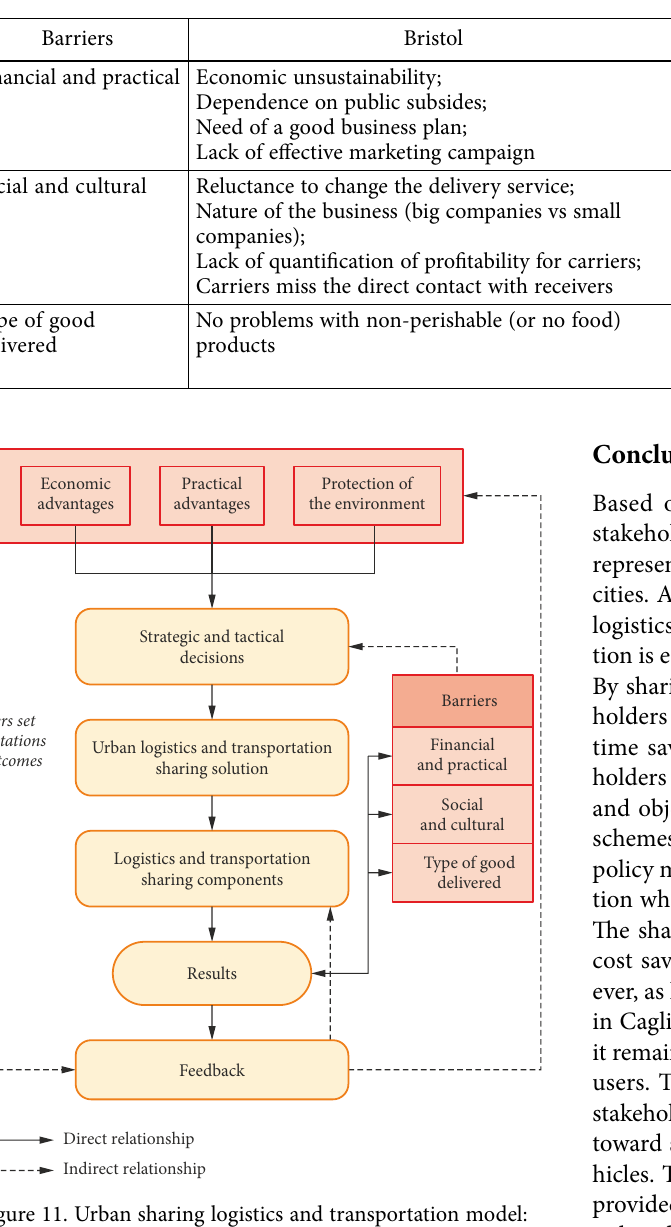
Figure 11. Urban sharing logistics and transportation model: drivers and barriers to the